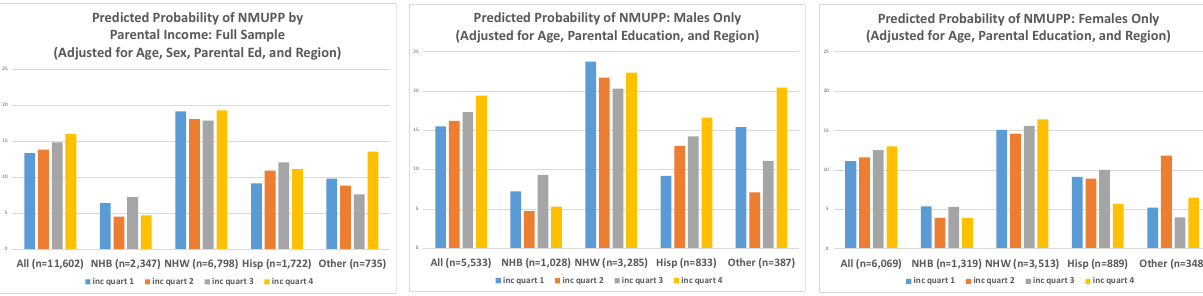
Figure 2. Model-based predicted prevalence of reported NMUPP at Wave 4 (adjusted for age, sex, parental education, and region of country) Note: “NHB” = non-Hispanic black; “NHW” = non-Hispanic white; “Hisp” = Hispanic. Table 3 notes: Prevalence for sample adjusted for age, sex, parental education reported by parent at Wave 1 (< high school; high school; some college; college; more than college), and region of country (Northeast, Midwest, West, South) using model-based predicted values. 1 p -values for quartile trend reflect results from extension of (non-parametric) Wilcoxon rank-sum tests (nptrend command in Stata, testing trend for ranks across ordered groups). “NHB” = non-Hispanic black; “NHW” = non-Hispanic white.